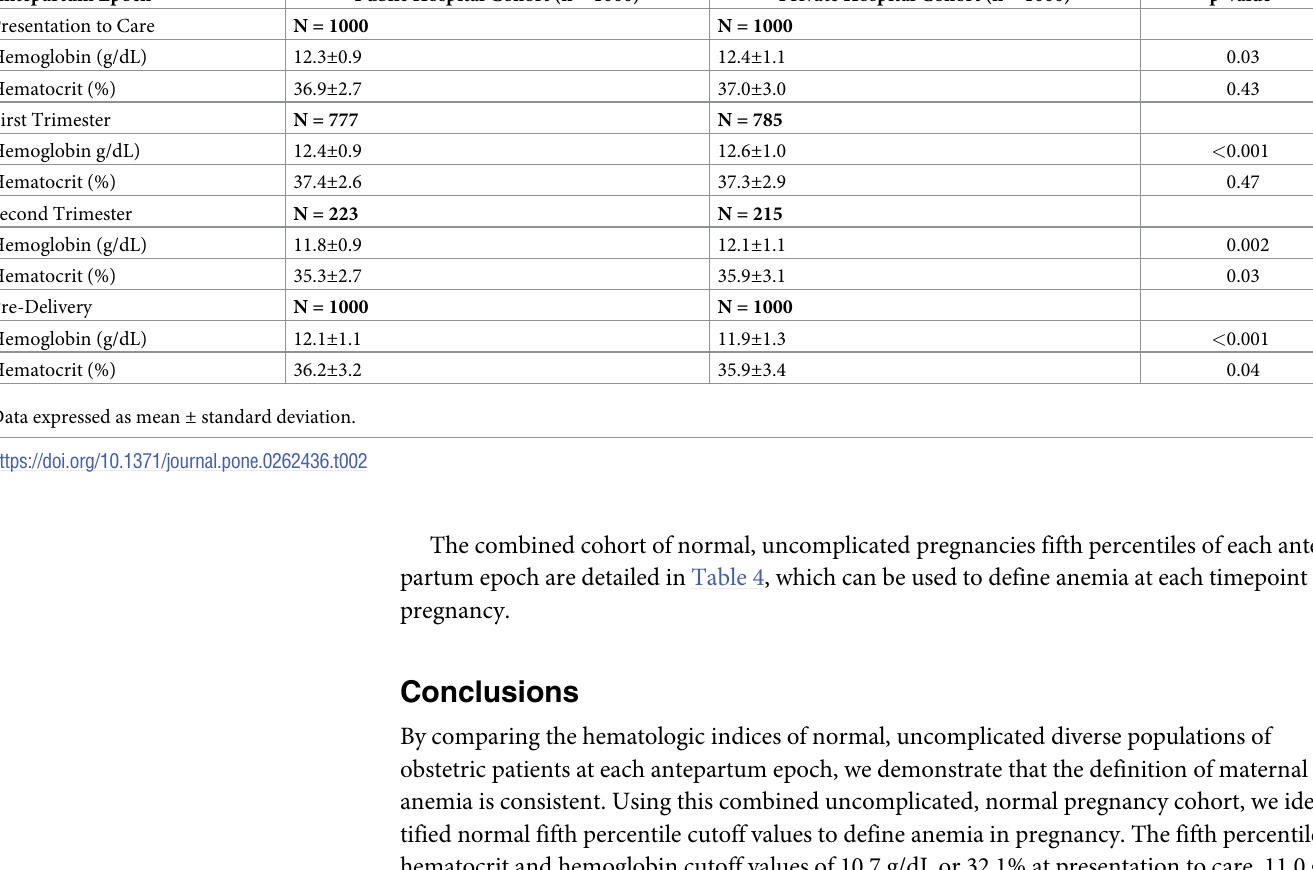
Table 3. Comparison of fifth percentile estimates between cohorts by antepartum epoch. Antepartum Epoch